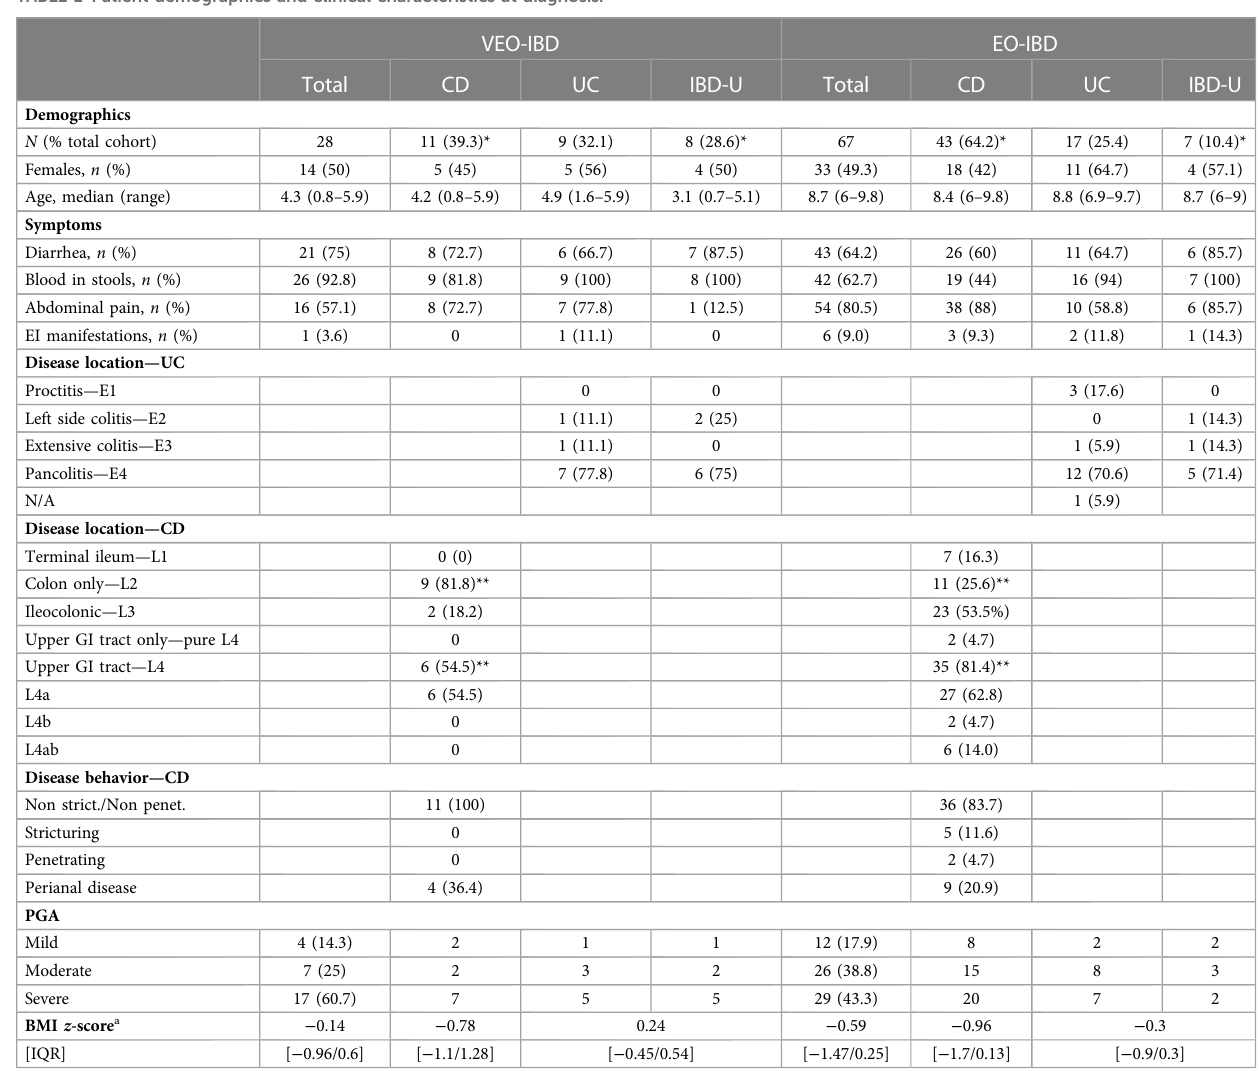
TABLE 1 Patient demographics and clinical characteristics at